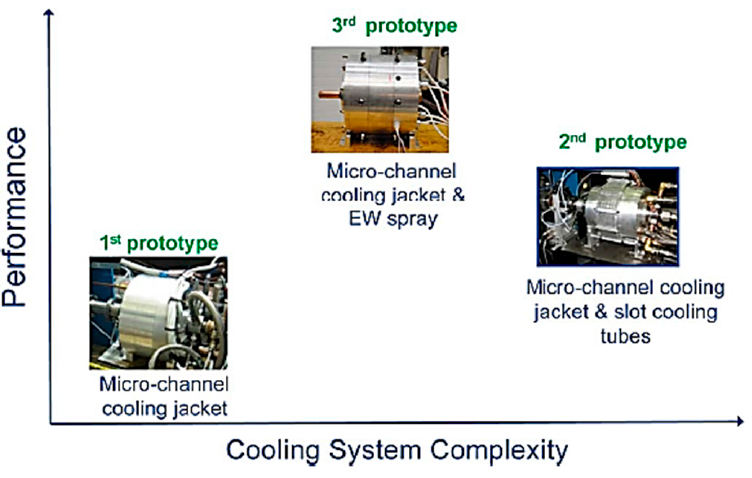
Figure 28. Comparison of cooling schemes [68].